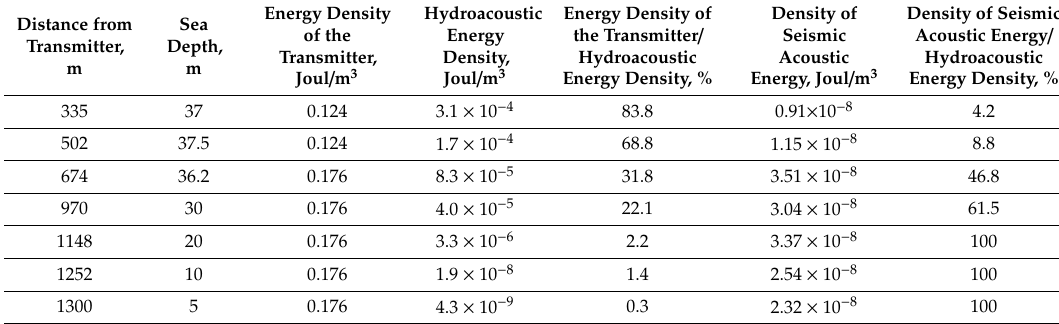
Table 2. The calculated